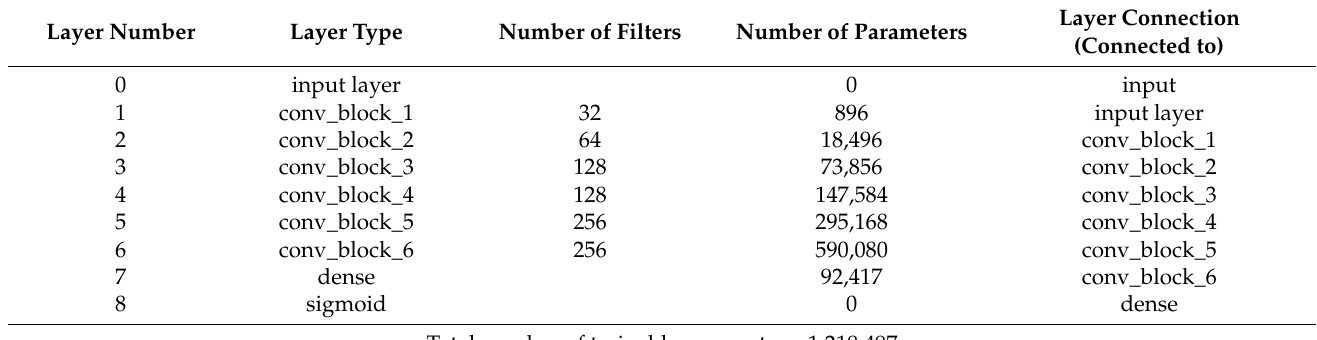
Table 7. Description of the discriminator of